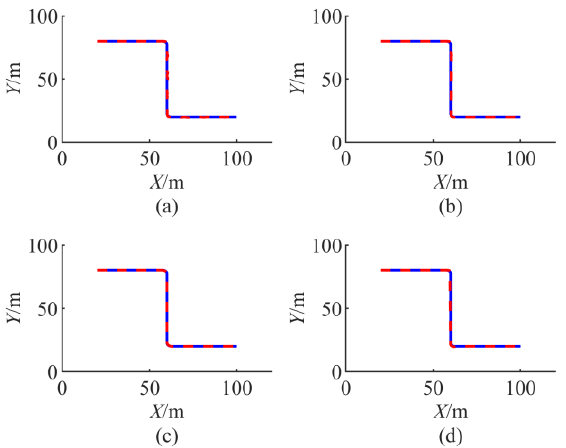
Figure 21. The trajectory when parameters changed. The red line is the trajectory. The blue line is the reference path. ( a ) LMPC. ( b ) LEMPC. ( c ) NMPC. ( d ) NEMPC.